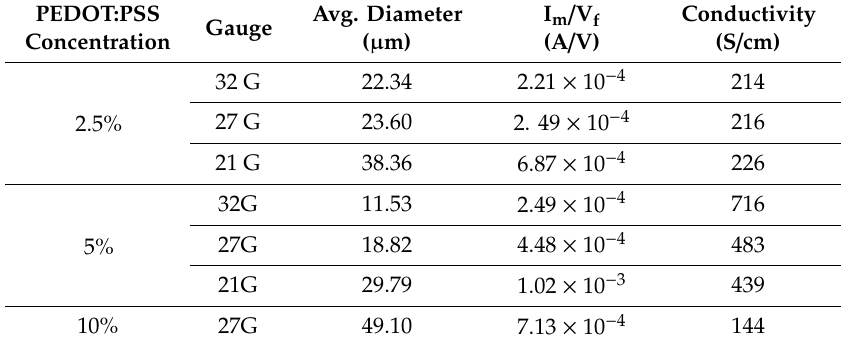
Table 1. Diameter measurement and conductivity of fibers spun from PEDOT:PSS aqueous solution µ m, 210 µ m, and 108 µ m, respectively). The average values from three di ff erent fibers are